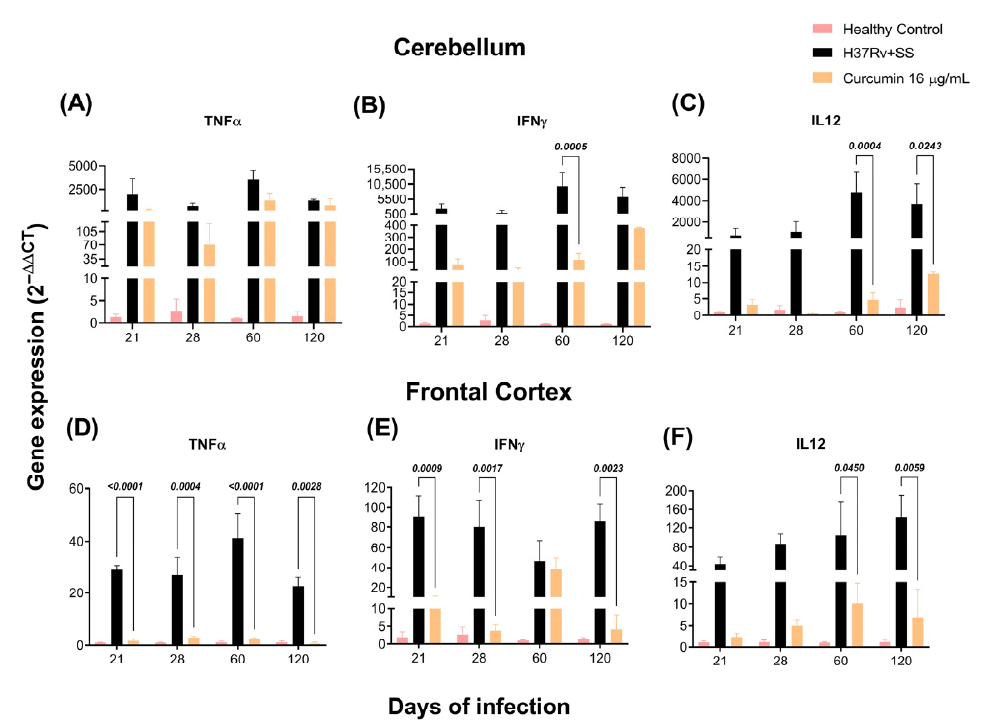
Figure 4. Effect of curcumin (CUR) treatment (16 µ g/mL) on pro-inflammatory cytokines of the cerebellum and frontal cortex of mice infected with 2.5 × 10 5 Mtb colony-forming units (CFU) virulent strain H37Rv, mice that received saline solution (SS) as the vehicle, and mice that were not infected and were used as controls. ( A ) TNF α expression on the cerebellum. F (2, 6) = 4.211, p = 0.0720. REML ( B ) IFN γ expression on the cerebellum. F (2, 6) = 7.322, p = 0.0245. REML. Tukey’s multiple comparisons test ( C ) IL-12 expression on the cerebellum. F (2, 21) = 14.39, p = 0.0001. REML. Tukey’s multiple